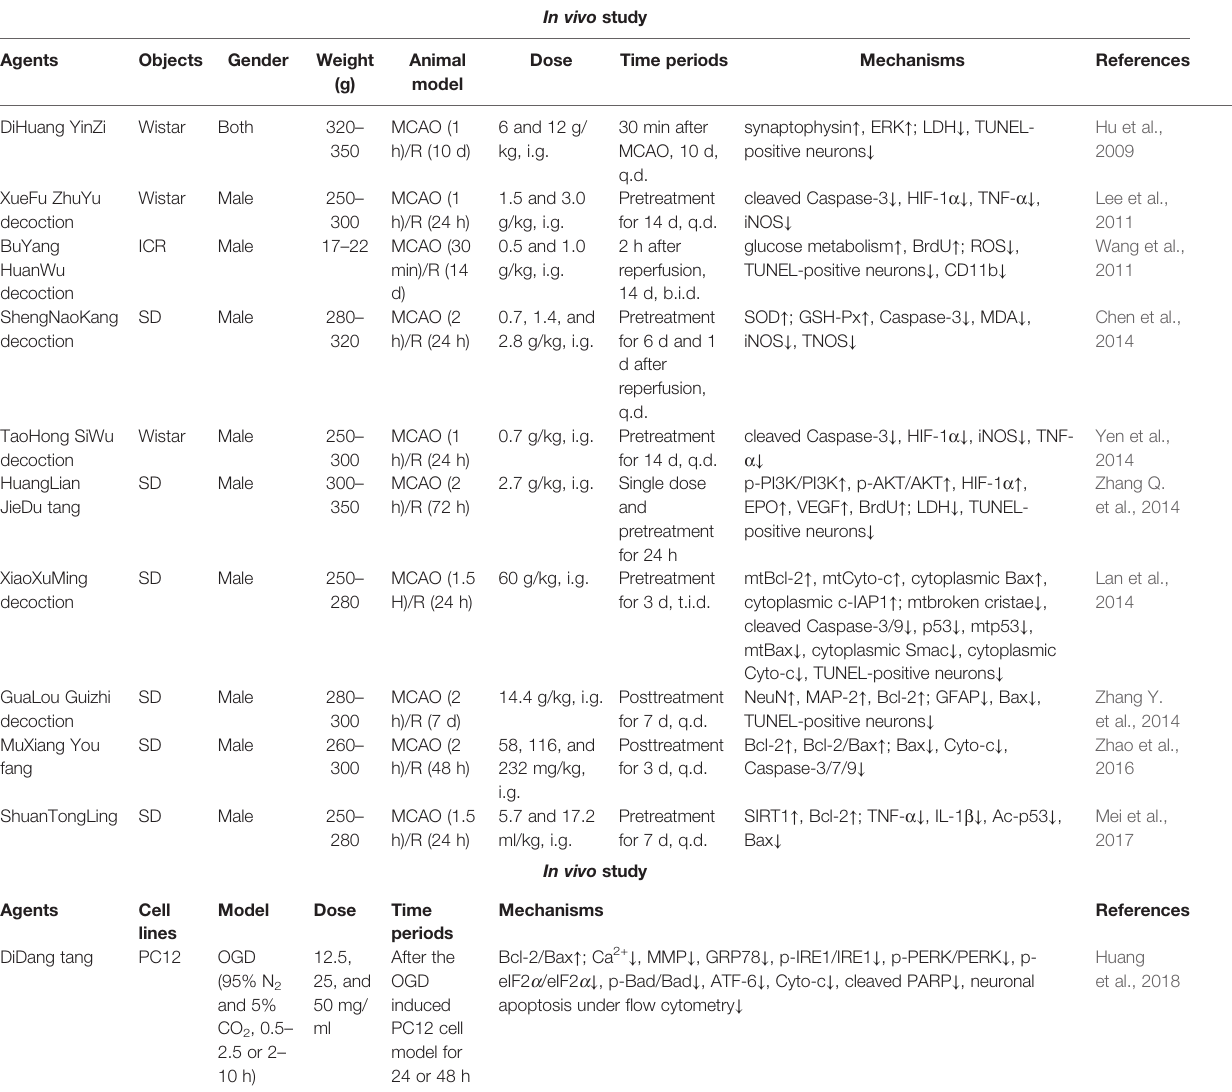
TABLE 3 | The in vivo and in vitro mechanism underlying the inhibition of MPTP opening-induced neuronal apoptosis by TCM prescriptions in the treatment of ischemic stroke.